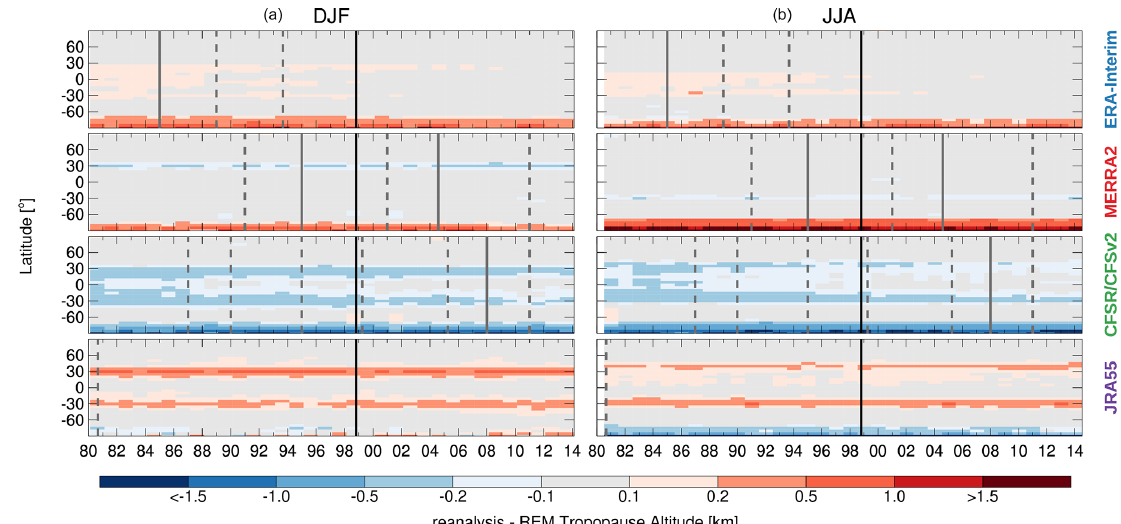
Figure 9. 2PVU tropopause altitude zonal mean differences for each reanalysis from the REM as a function of year. (a) DJF and (b) JJA differences. Vertical lines show the discontinuities associated with changes in assimilated datasets or different processing streams.